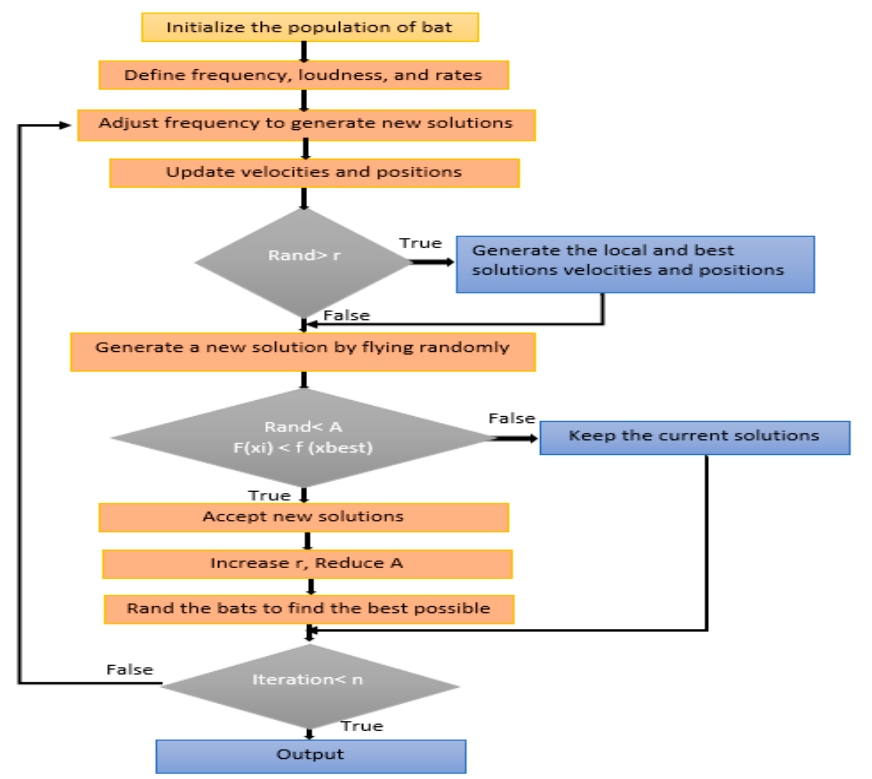
Figure 10. BAT algorithm flowchart.